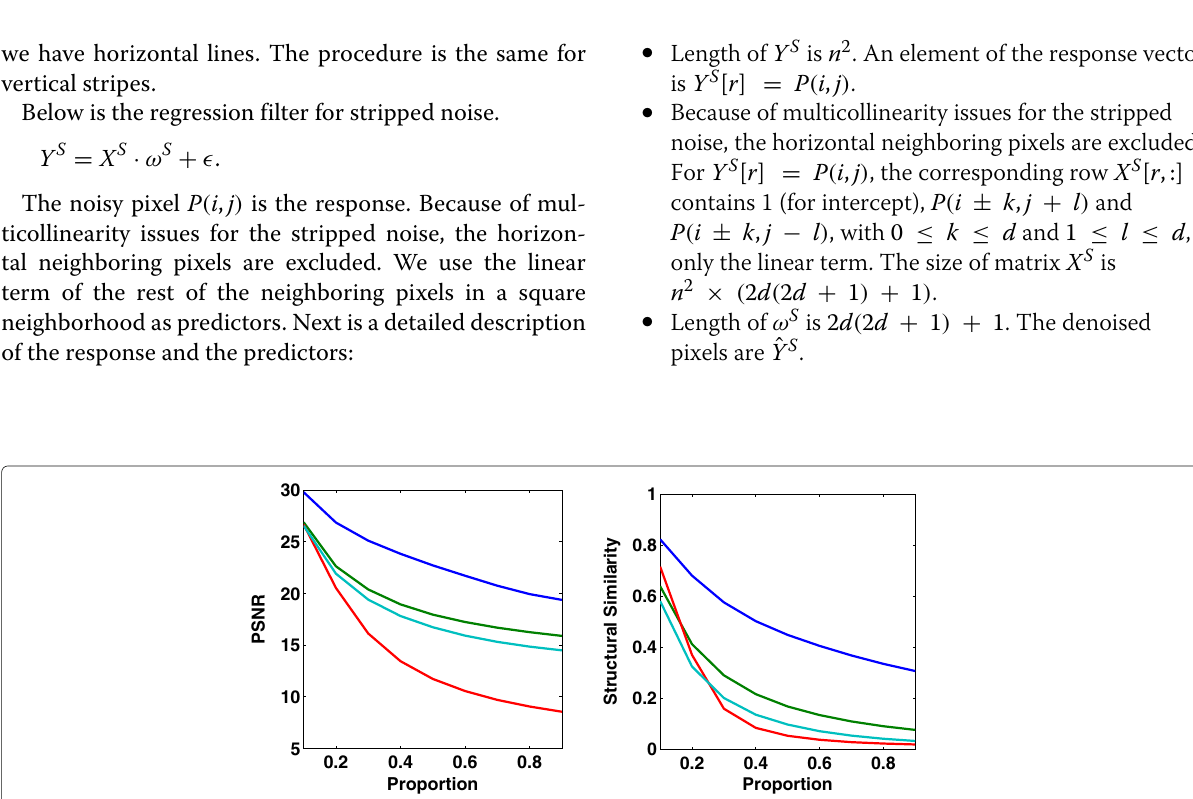
we have horizontal lines. The procedure is the same for vertical stripes.